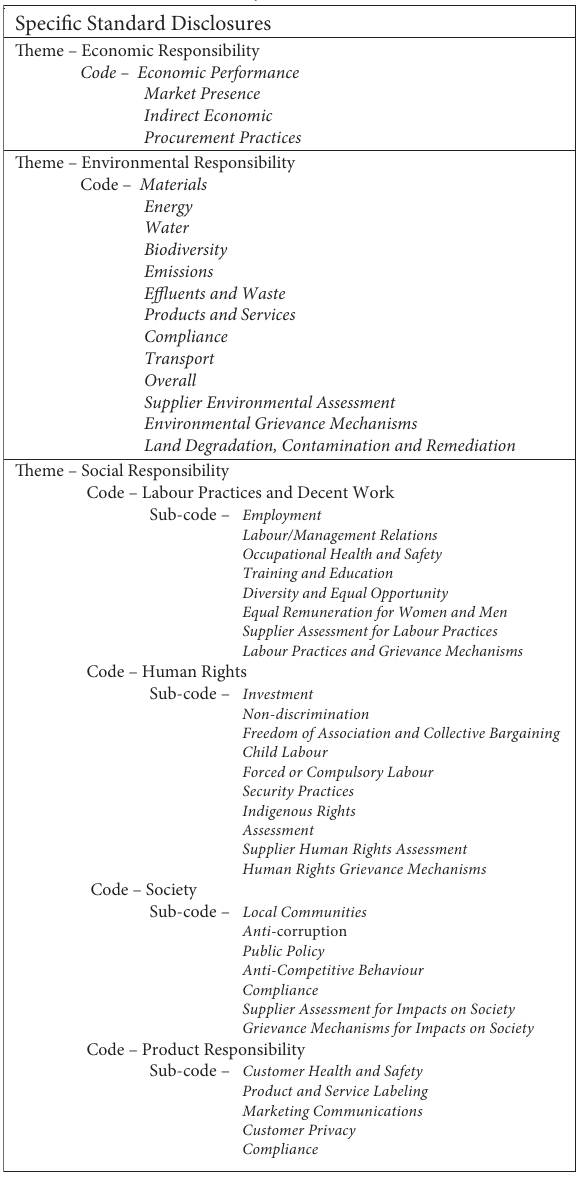
Figure 1. Coding system – Quantity of information based